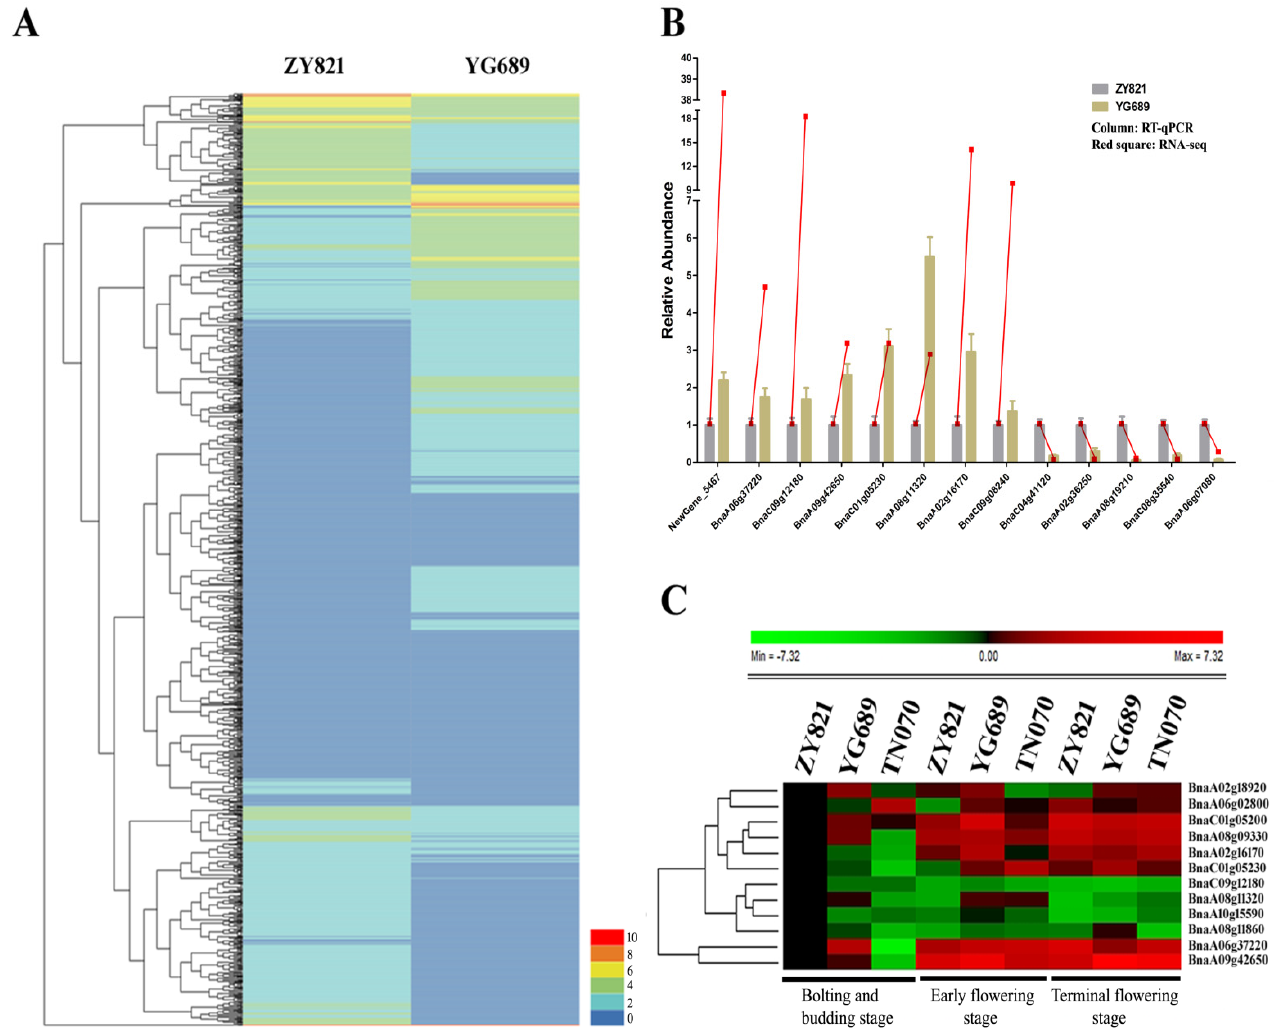
Figure 3. ( A ) Heatmap analysis of differentially expressed genes between YG689 and ZY821. RPKM (reads per kb per million reads) was used to calculate gene expression level. The color key (0, 2, 4, 6, 8, 10) represents FPKM normalized log(10) transformed counts. Red represents high expression and blue represents low expression. Each row represents a gene. ( B ) Validation of differentially expressed genes by RT-qPCR. Thirteen DEGs were randomly chosen for RT-qPCR validation using ZY821 transcript expression levels as the control. The relative expression levels of each gene are expressed as the fold change between ZY821 and YG689. The B. napus ACT 7 actin gene is used as an internal control. Histogram indicated the relative expression level between ZY821 and YG689 from RT-qPCR results and red square indicated the relative expression level between ZY821 and YG689 from RNA-seq. ( C ) Heatmap analysis of lignocellulose-related DEGs among ZY821, YG689, and TN070. The color key represents relative expression levels normalized log 2-transformed counts. Red represents high expression and green represents low expression. Each row represents a gene ( n = 3).